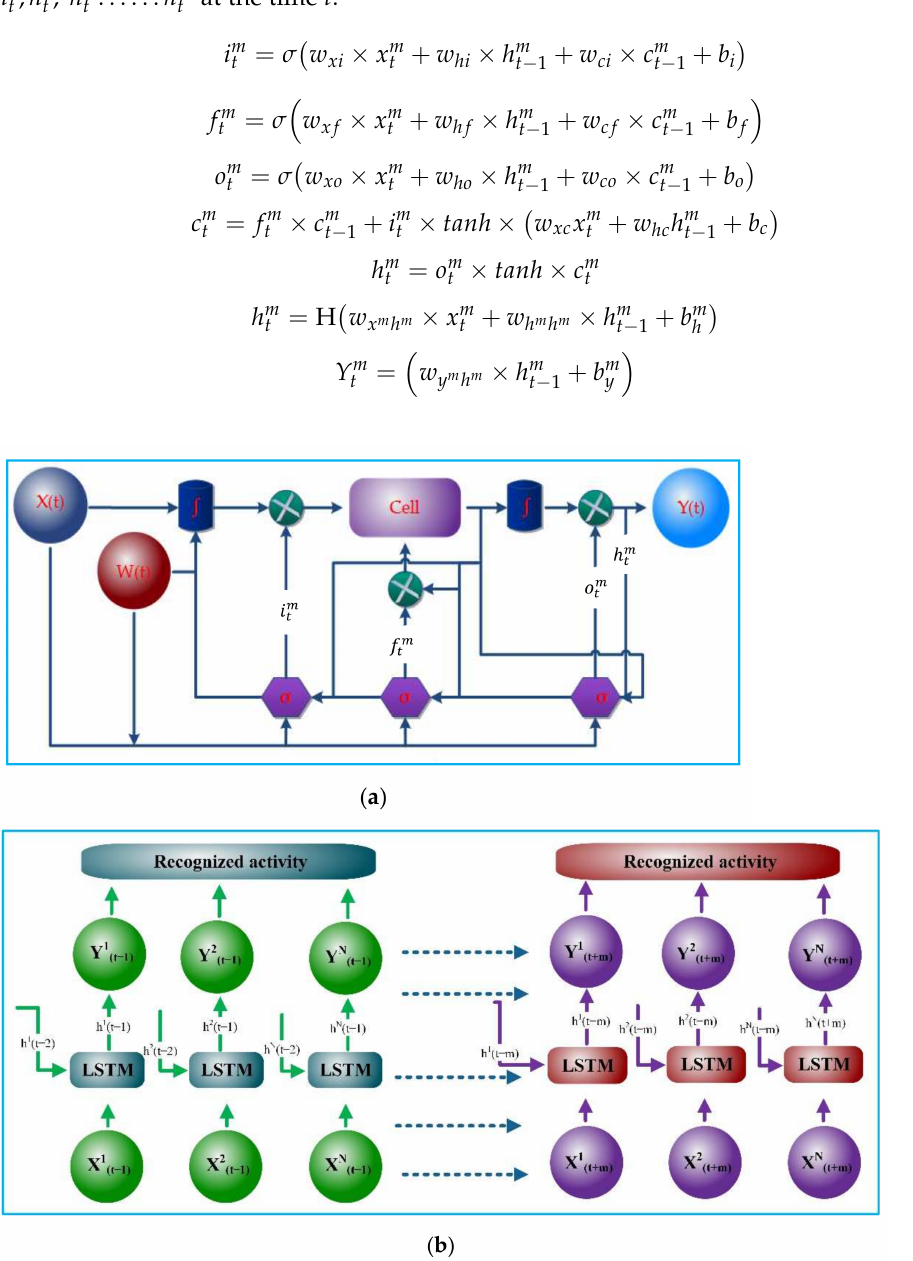
Figure 2. ( a ) Internal Architecture of sync-LSTM; ( b ) Unfold of